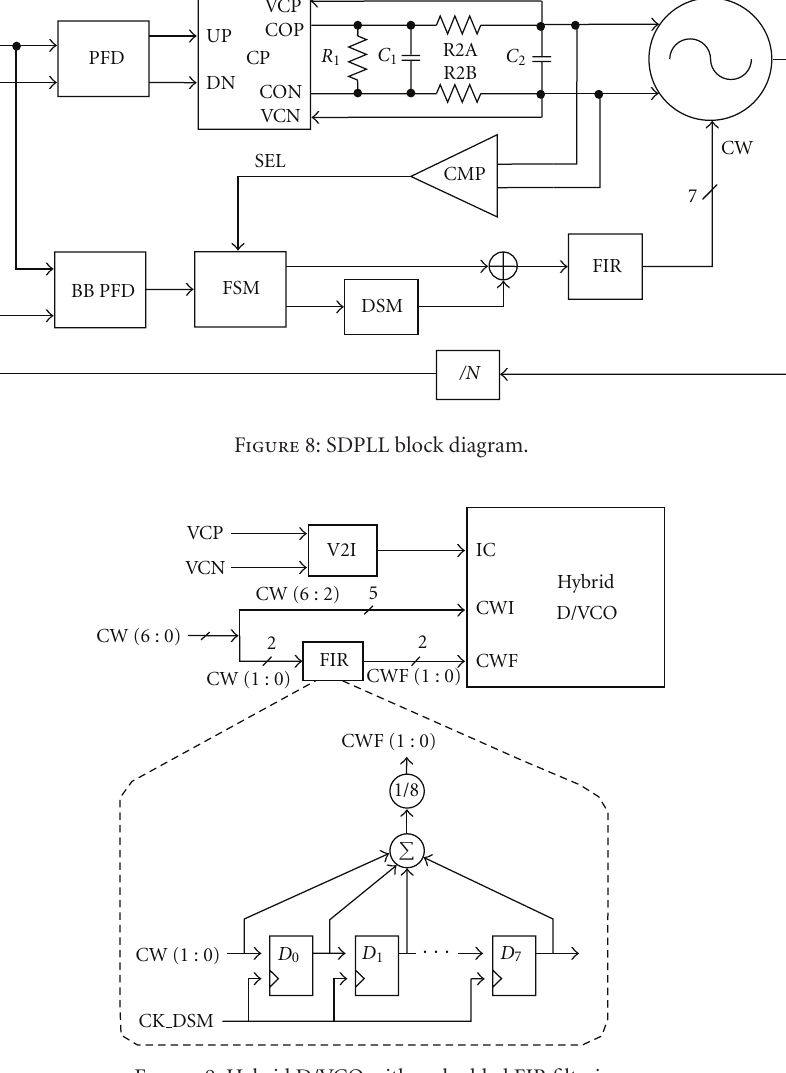
Figure 9: Hybrid D/VCO with embedded FIR